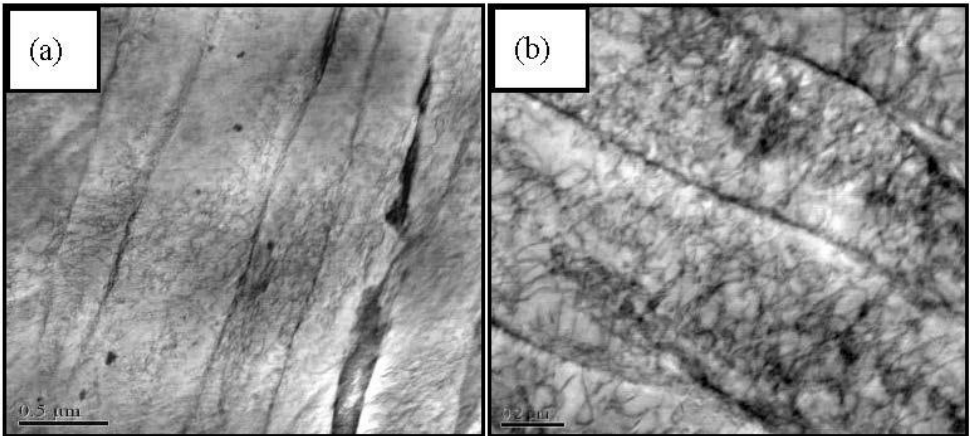
Figure 6. The TEM (transmission electron microscope) micrographs of the typical microstructure morphology in the specimen with heat input of 30 kJ/cm: ( a ) fine bainite ferrite lath; ( b ) dislocation distribution.